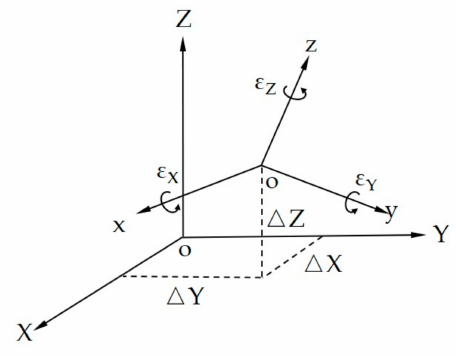
Figure 5. BASE and TOOL space rectangular coordinate